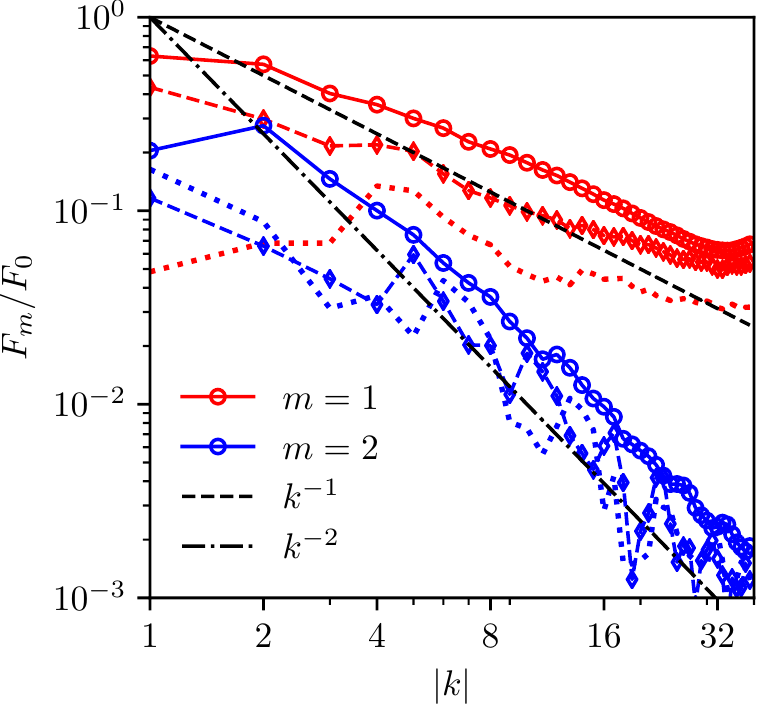
Figure 6. Dependence of the angular modes on k for runs with f = 0.002. Solid lines with circles are for 10 short runs, averaged in the reference frame of the anisotropy vector, as in Figure 3. Dashed lines with diamonds are for one long run, averaged in the reference frame of the anisotropy vector, as in Figure 2; dotted lines are for the long run averaged in a static reference frame. One obtains similar results averaging over in the local frame over 10 relatively short runs (4000 dimensionless time), all started from the same state with randomized phases, as shown in Figure 5, which is counterpart to Figure